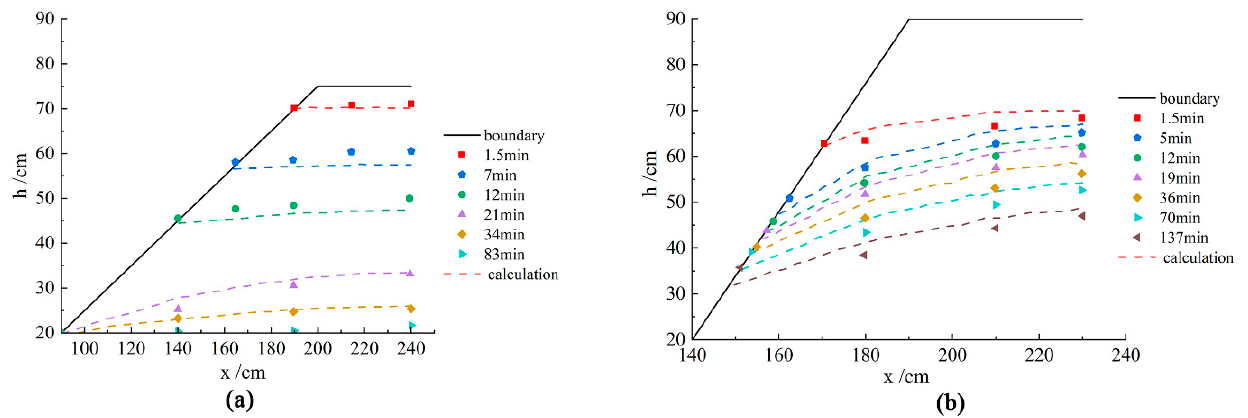
Figure 7. Comparison of results of different soil model tests and numerical simulation: ( a ) medium sand; ( b ) silt.